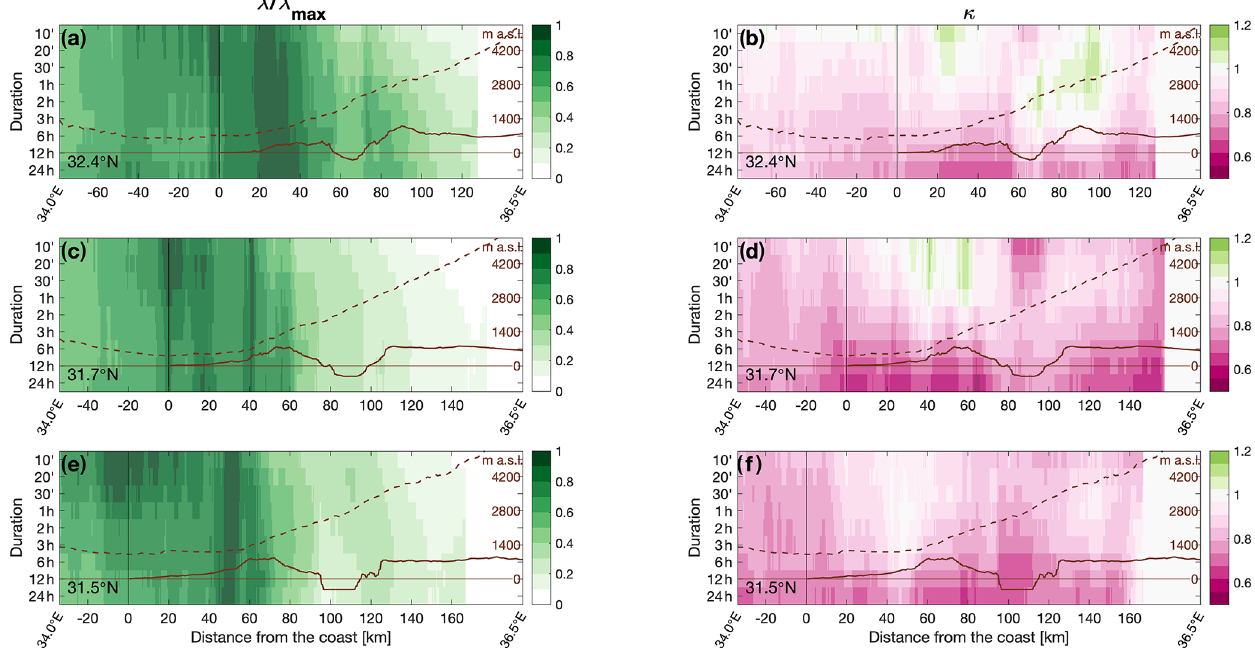
Figure 6. Longitudinal variations in the scale (a, c, e) and shape (b, d, f) parameters along the three transects (see Fig. 1) as a function of the distance from the coastline ( x axis) and of duration ( y axis). Transects are obtained by averaging the 10km region surrounding the three latitudes. The terrain profile and the sampling height of the lowest non-blocked radar beam are superimposed as solid and dashed lines, respectively (see right hand-side y axis). In order to have comparable values, the scale parameter (a, c, e) at each duration is normalized over the maximum value along